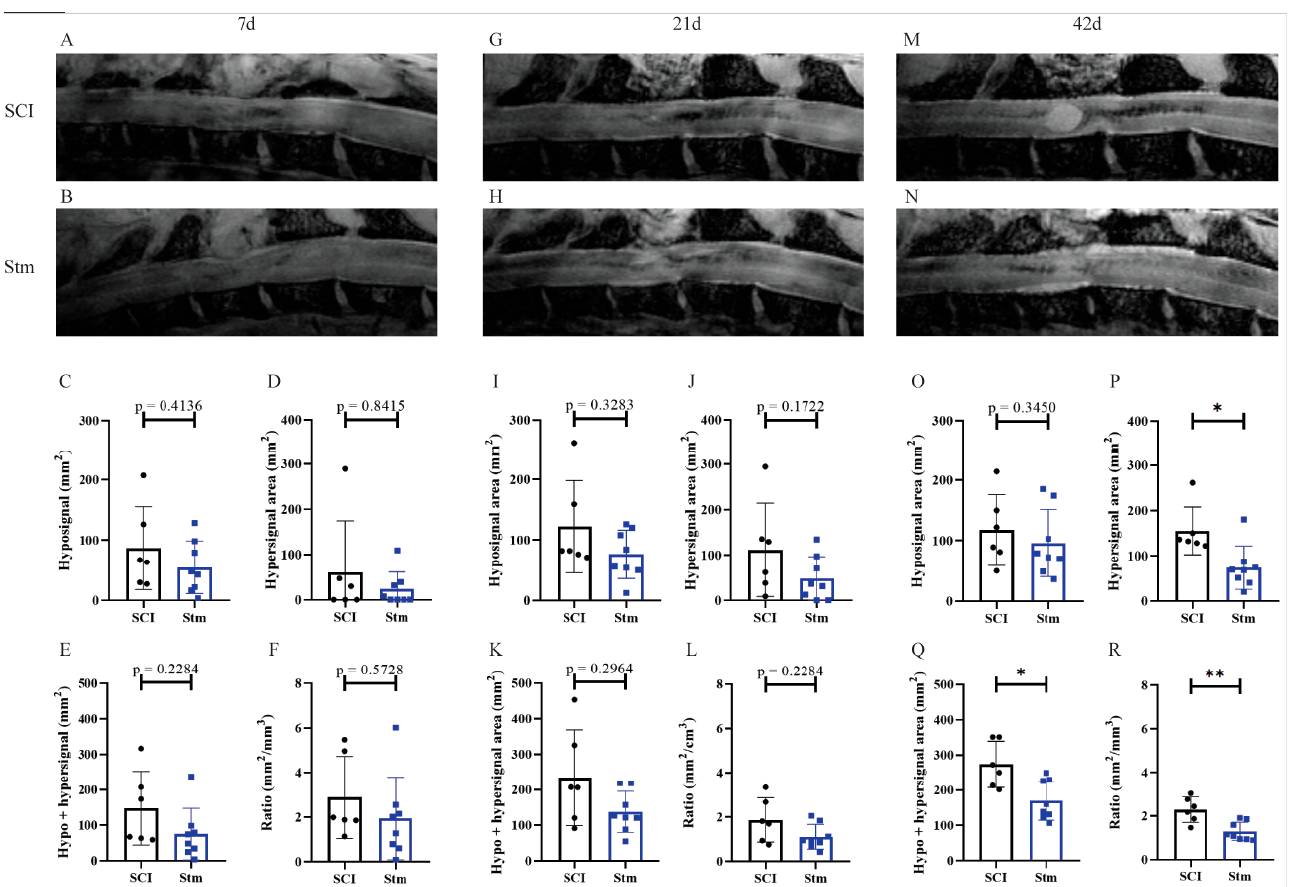
Figure 7. MRI analyses show that rTSMS treatment decreases cystic cavities and increases spinal cord spared tissue. At ( A – F ) 7, ( G – L ) 21 and ( M – R ) 42 days, MRI experiments were performed. Representative images of sagittal spinal cord sections recorded with MRI of ( A , G , M ) SCI and ( B , H , N ) Stm (rTSMS treated) animals. Quantification of hyposignal area ( C ) 7, ( I ) 14 and ( O ) 42 days after SCI. Quantification of hypersignal area ( D ) 7, ( J ) 14 and ( P ) 42 days after SCI. Quantification of hypo + hypersignal area ( E ) 7, ( K ) 14 and ( Q ) 42 days after SCI. Quantification of ratio lesioned tissue ( F ) 7, ( L ) 14 and ( R ) 42 days after SCI; n = 6 animals per control group and n = 8 per Stm group. Quantifications are expressed as average ± SD. Statistical evaluations are based on the Mann–Whitney test (* = p < 0.05 and ** = p <